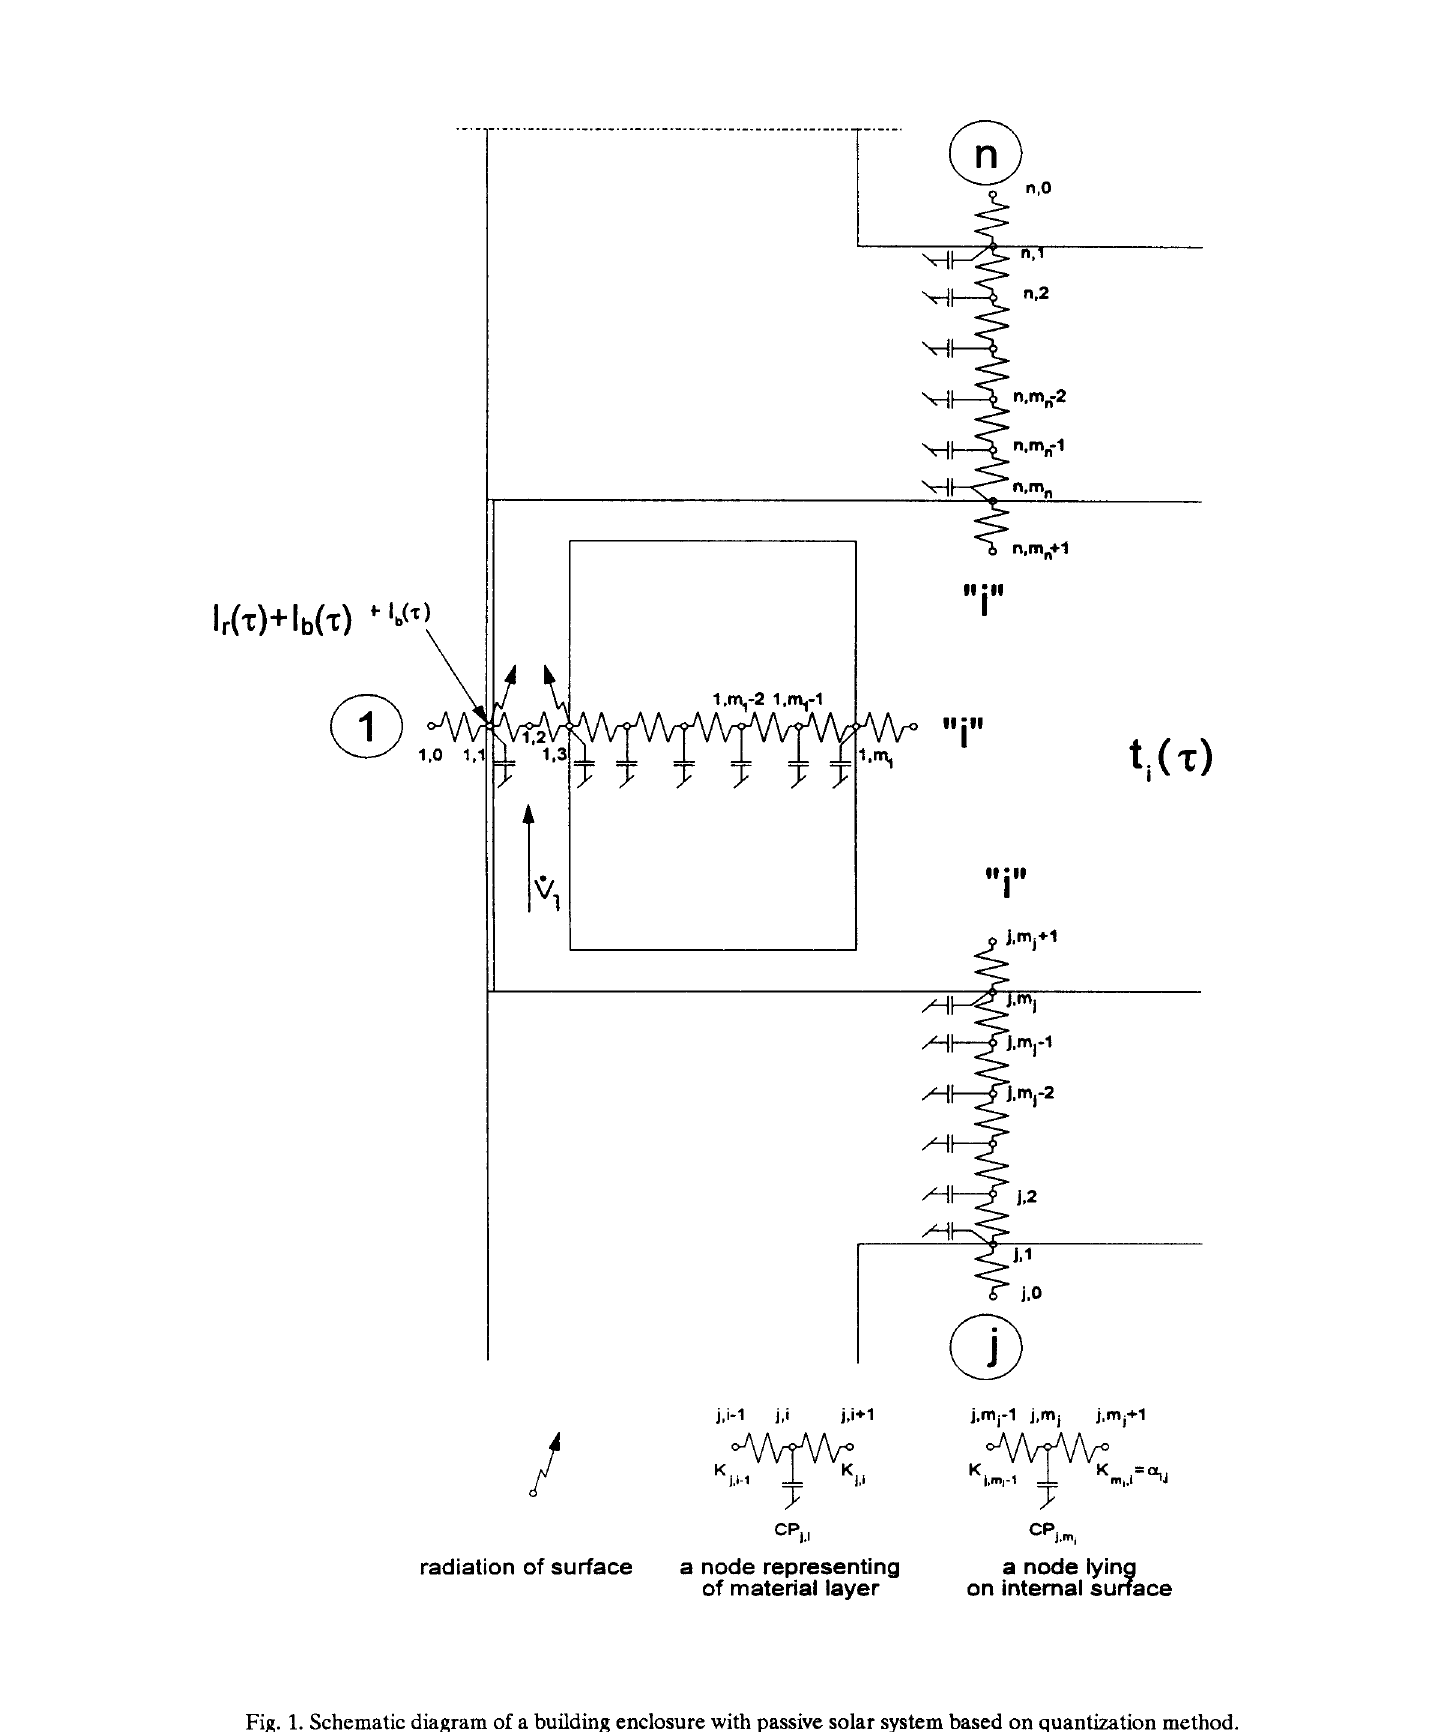
Fig. 1. Schematic diagram of a building enclosure with passive solar system based on quantization method.